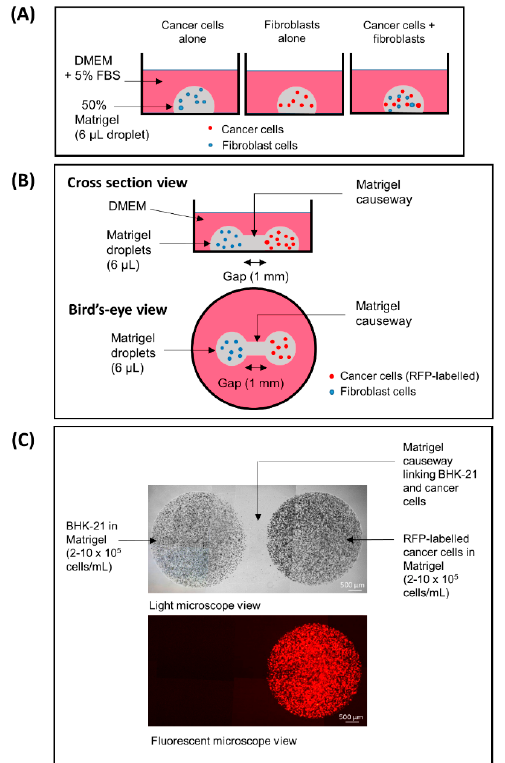
Figure 1. ( A ) A conventional 3D co-culture model, ( B , C ) a “3D dumbbell model” invented in this study for the visualization of cancer-fibroblast cell interaction. ( A ) CaKi-1 and BHK-21 fibroblast cells embedded in 50% Matrigel suspension (6 µ L / droplet; containing 5 × 10 5 cells / mL) as independent or co-culture droplets. ( B ) Caki-1 cells and BHK-21 fibroblasts in 50% Matrigel suspension (6 µ L / droplet; 5 × 10 5 cells / mL) droplets bridged by a Matrigel causeway that allows for cell migration and interaction. red under a fluorescent microscope. Brightfield and fluorescent views of the same cells under a 40 × low power objective